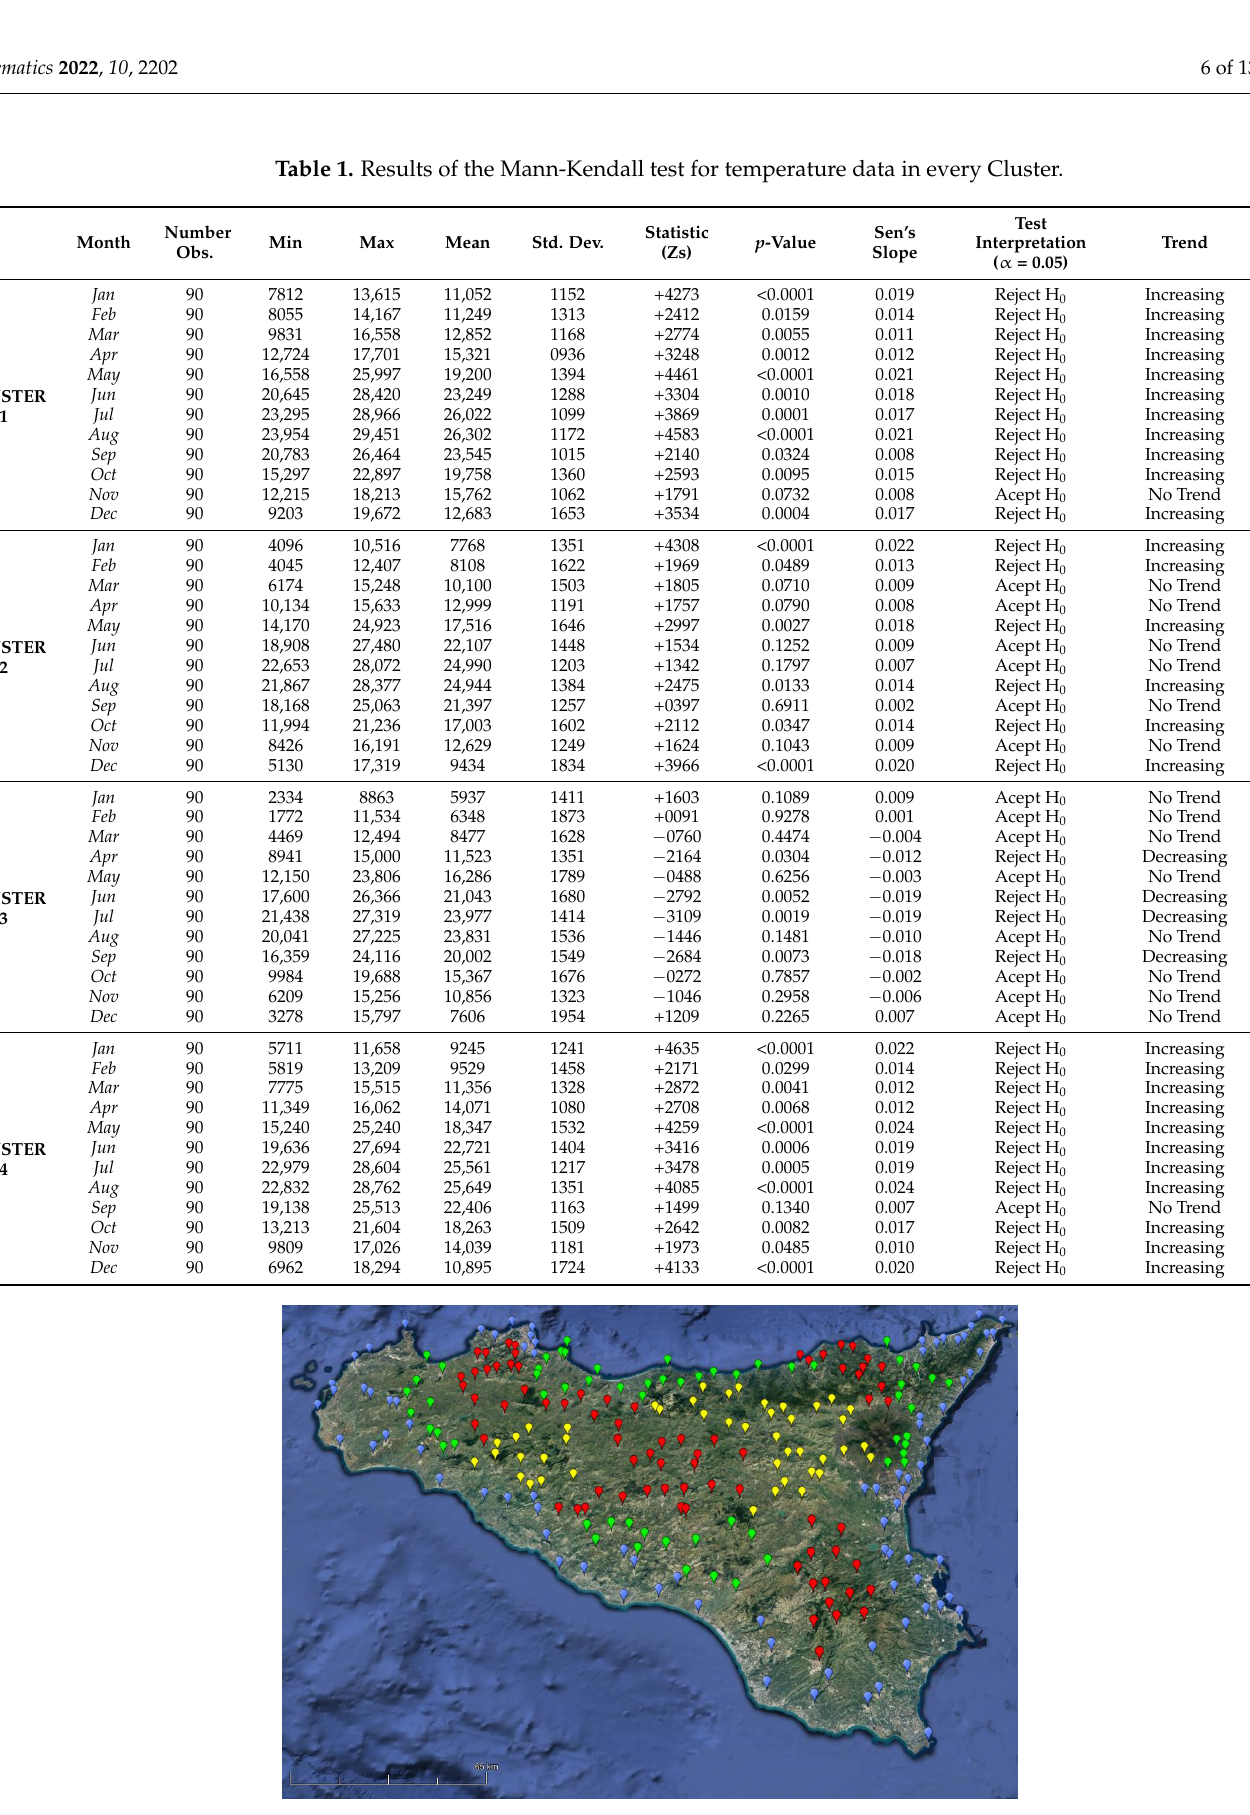
Figure 7. Spatial distribution of the Clusters. In detail in BLUE Cluster 1, in RED Cluster 2, in YELLOW Cluster 3, in GREEN Cluster 4.